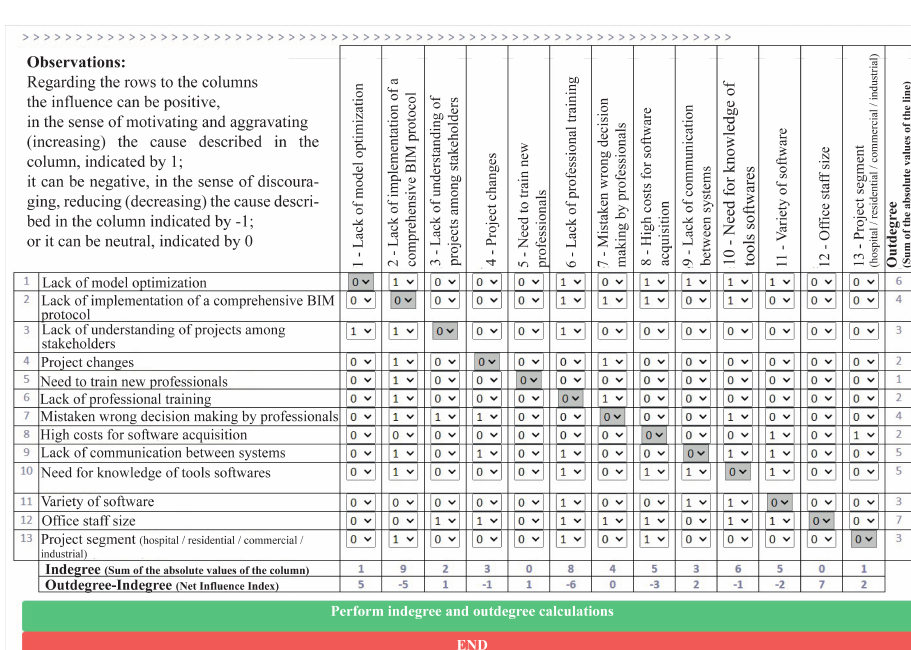
Figure 10. Selection of adversities.